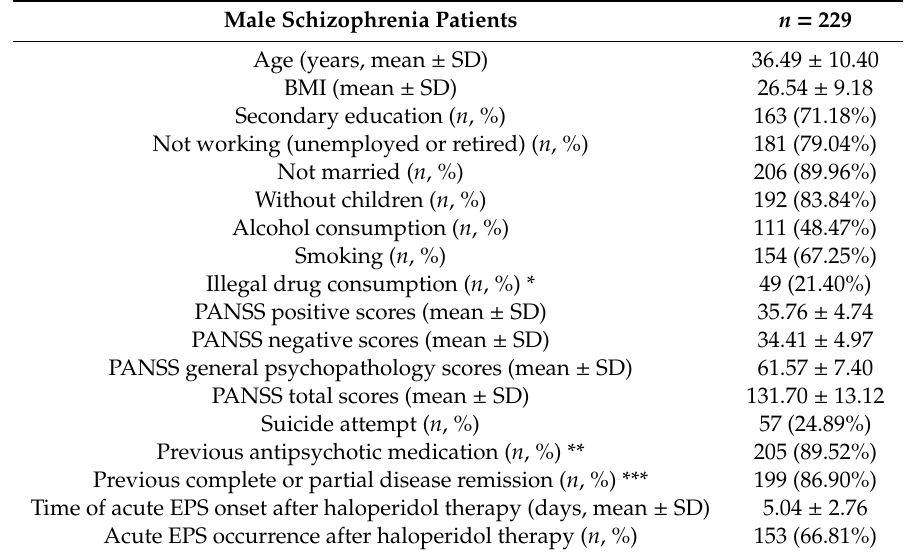
Table 1. Socio-demographic and clinical characteristics of haloperidol-treated schizophrenia